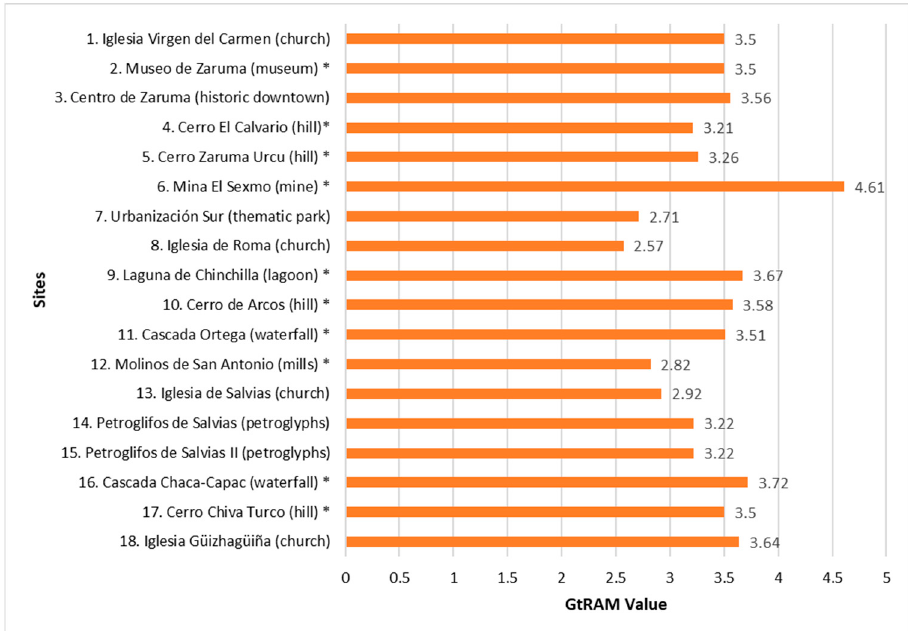
Figure 8. GtRAM evaluation of the geosites and mining sites that make up the GT-II route. * Geositest/mining sites.